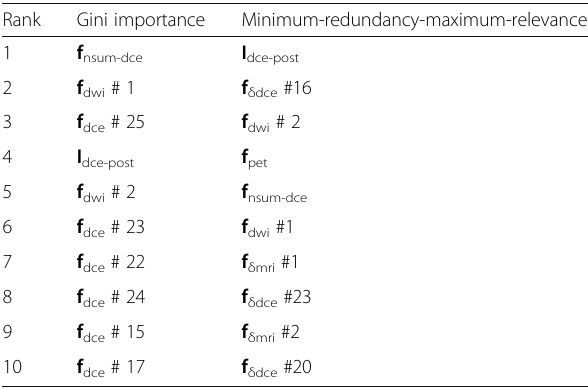
Table 4 Top-ranked segmentation features according to Gini importance and